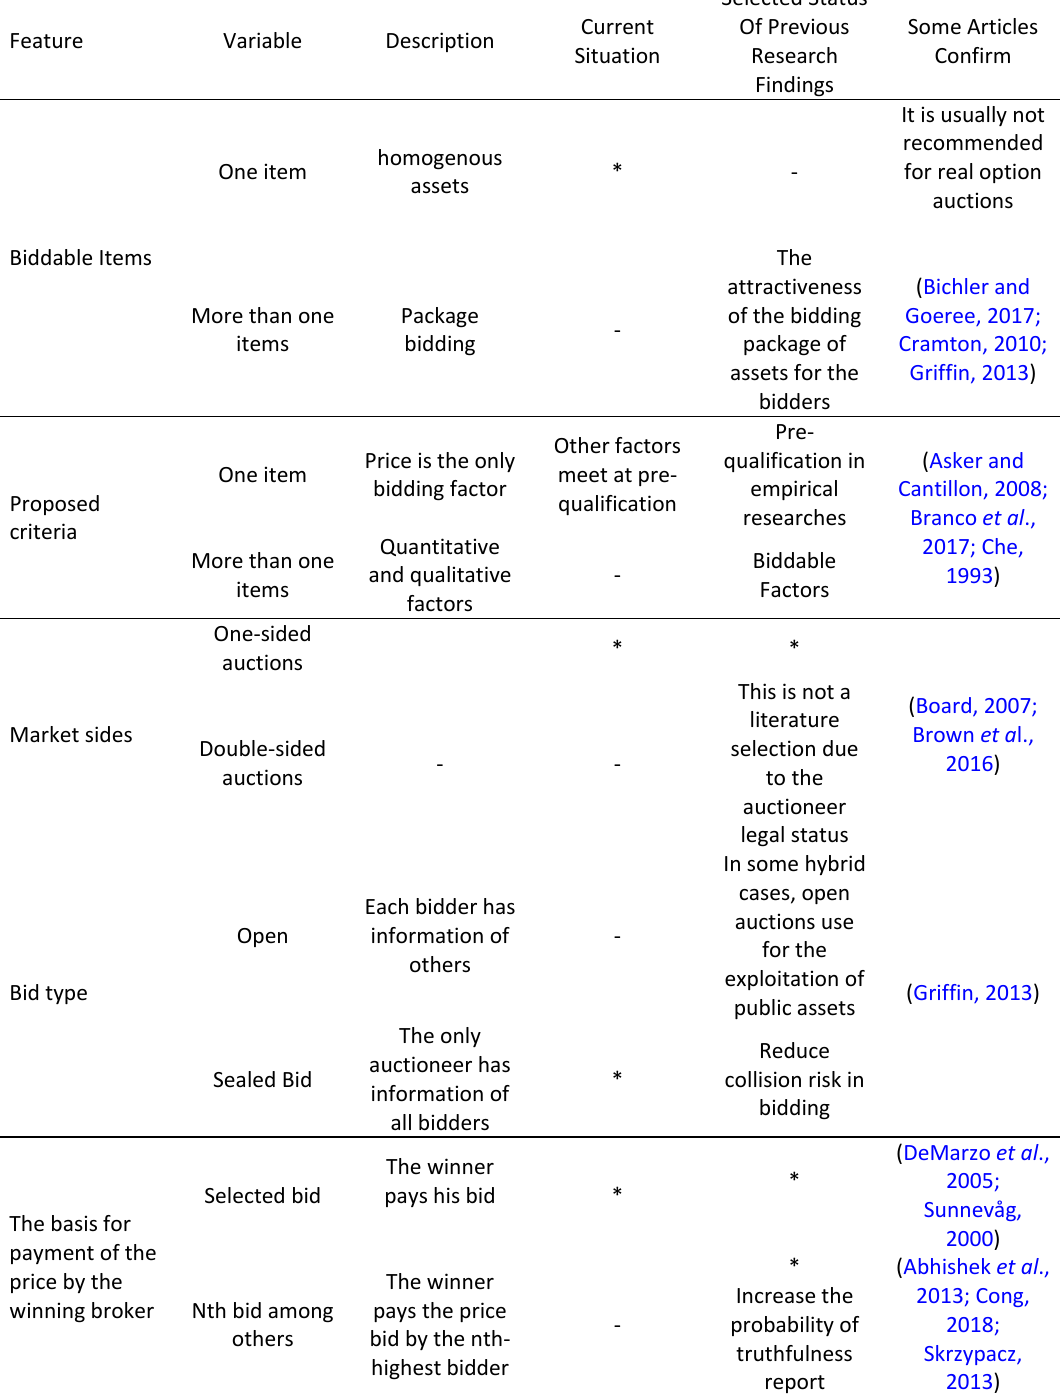
Table 2. Comparison of the status of rules of practice and the findings of previous research Table 2: Comparison of the status of rules of practice and the findings of previous